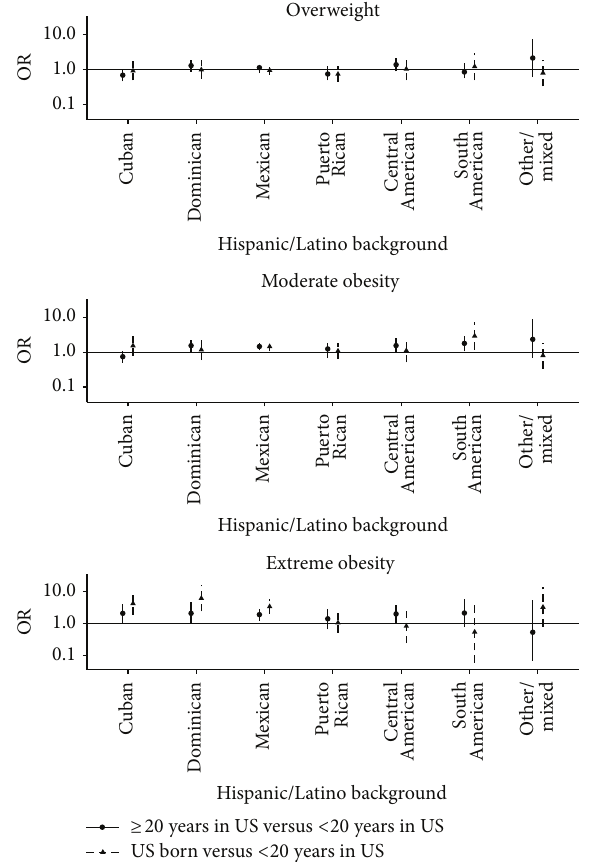
Figure 2: Odds ratio (OR) for the association of years living in the US with overweight (BMI = 25–29.9 kg/m 2 ), moderate obesity (BMI = 30–39 kg/m 2 ), and extreme obesity (BMI ≥ 40 kg/m 2 ) by Hispanic/Latino background. Models are adjusted for age, sex, household income, educational attainment, acculturation field cen- ter, and sampling weights. Reference category is living in the US for < 20